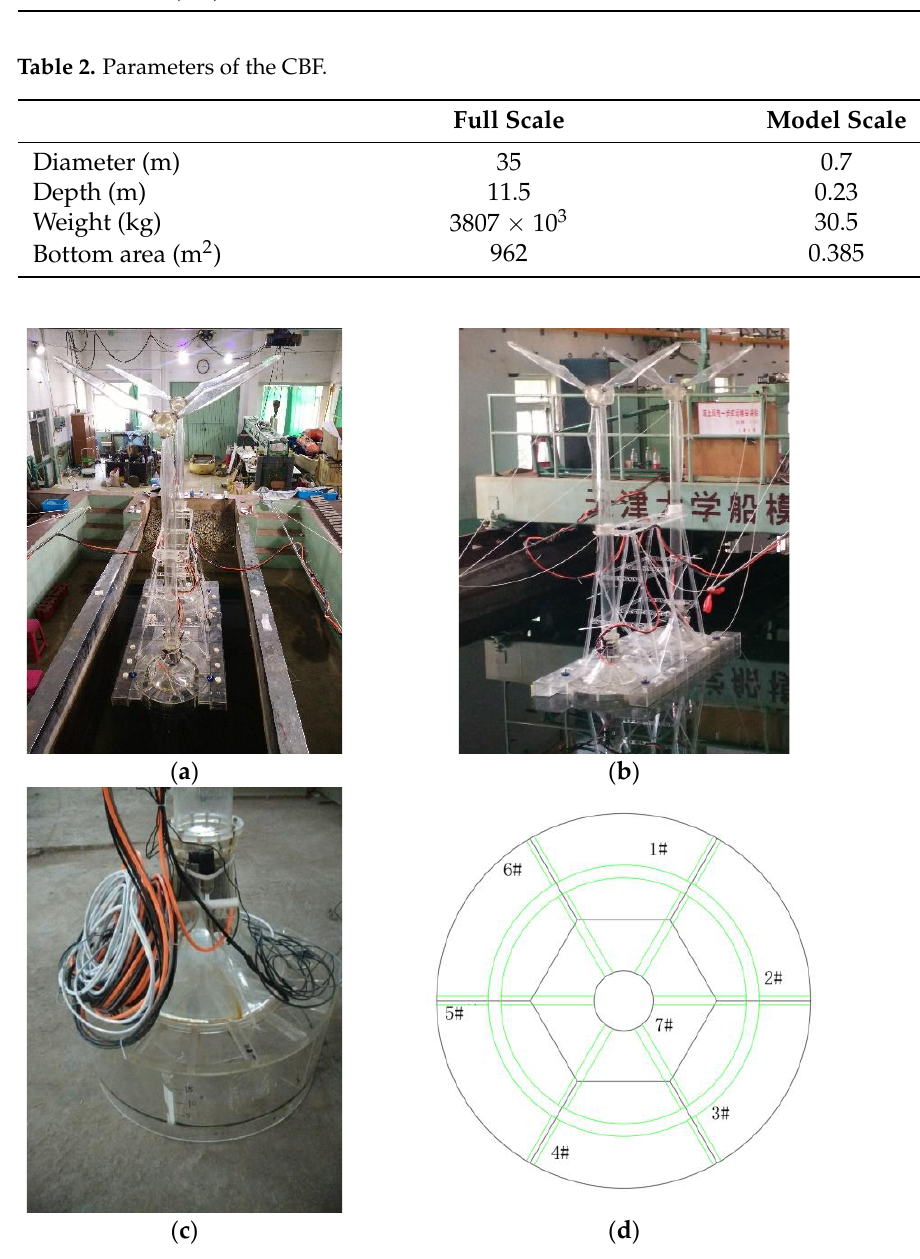
Figure 4. The vessel and the CBF model: ( a ) Installation of CBF; ( b ) Towing of CBF; ( c ) CBF model; and ( d ) 7 cabins of